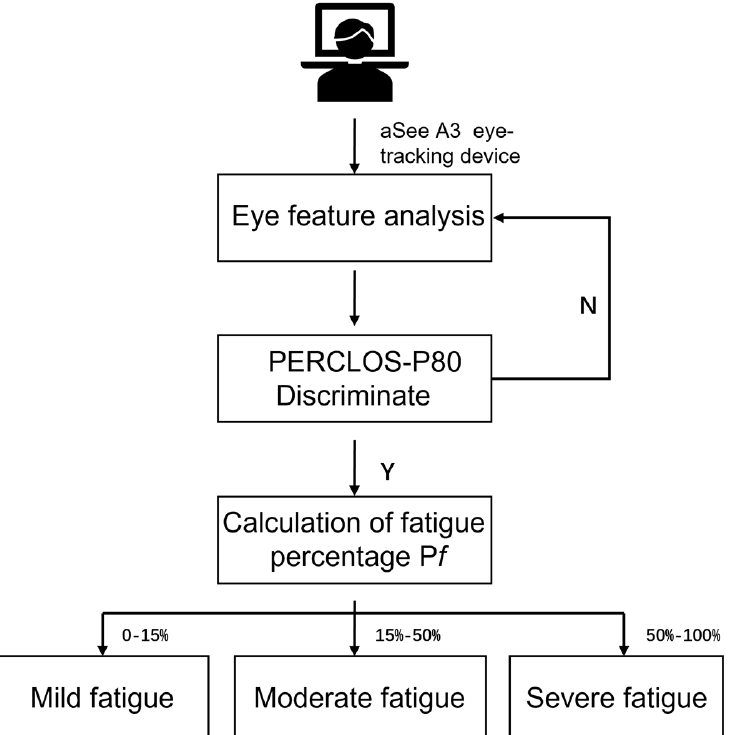
Figure 6. Flow chart of fatigue level